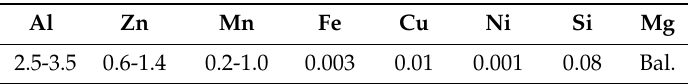
Table 1. The chemical composition of commercial AZ31 Mg alloys